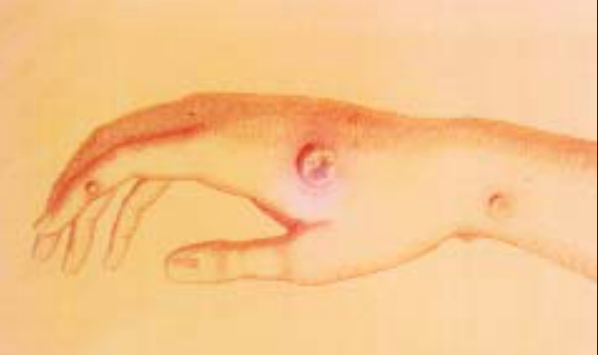
Figure 1) Plate 1 from Jenner’s Inquiry showing the cowpox lesions on the hand of Sarah Nelmes, one lesion of which was the source of mate-